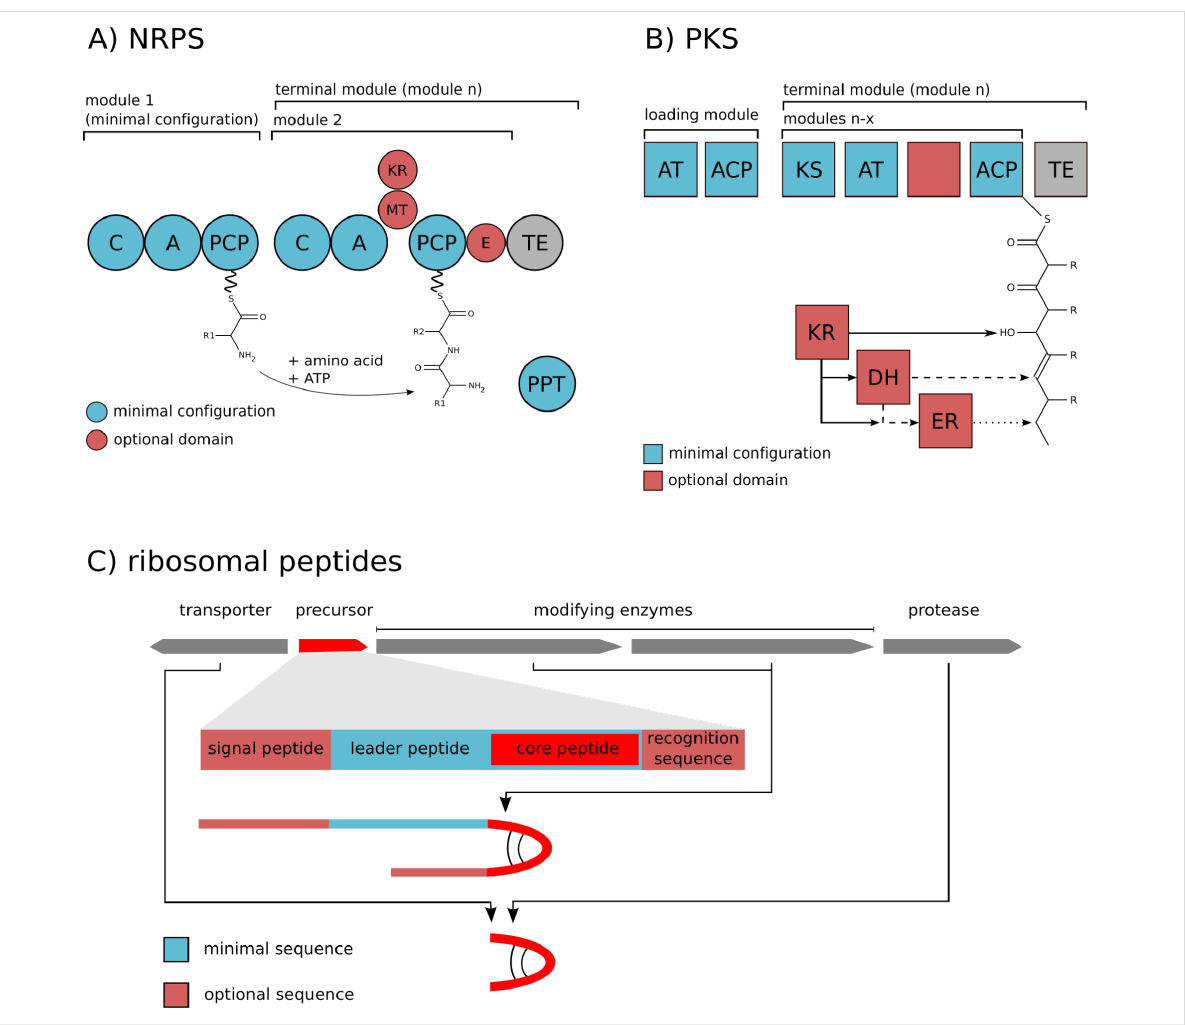
Figure 2: Schematic representation of enzymatic domains in A) nonribosomal peptide synthetases (NRPS); B) polyketide synthases (PKS) and C) the typical organisation of a ribosomal biosynthetic gene cluster. Abbreviations: C: Condensation domain; A: Adenylation domain; PCP: Peptidyl carrier protein; MT: Methyltransferase; E: Epimerase; AT: Acyltransferase; ACP: Acyl carrier protein; KS: Ketosynthase; KR: Ketoreductase; DH: Dehy- dratase; ER: Enoyl reductase; TE: